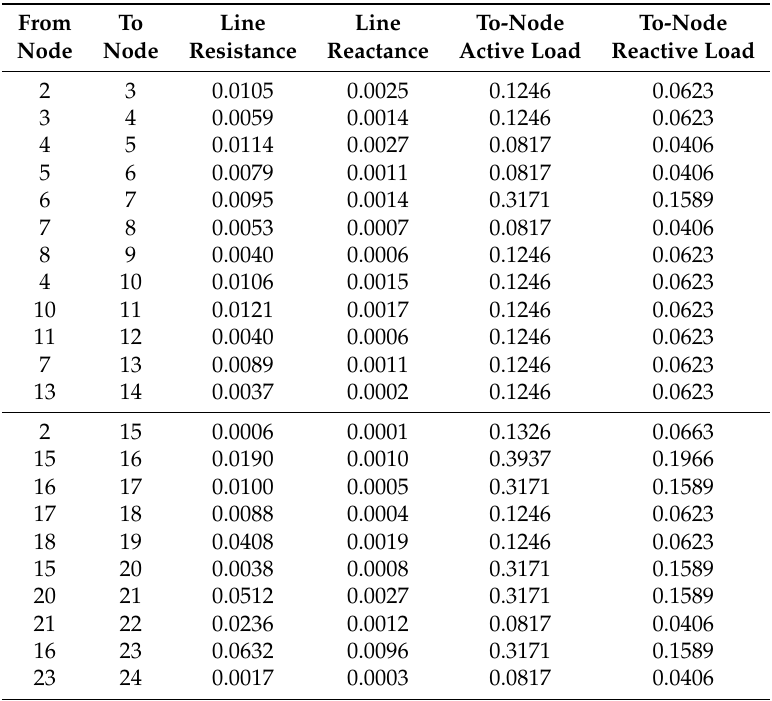
Table 1. Line and load parameters for the LV network